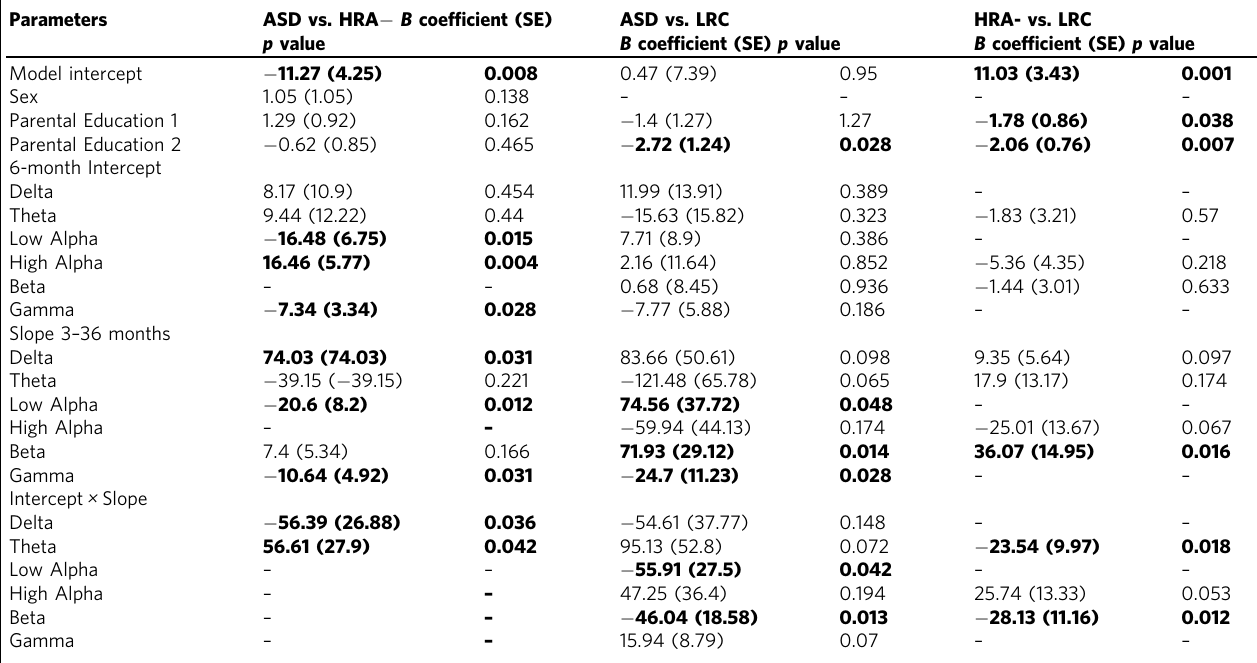
Table 4 Frontal 3 – 36 months EEG power models